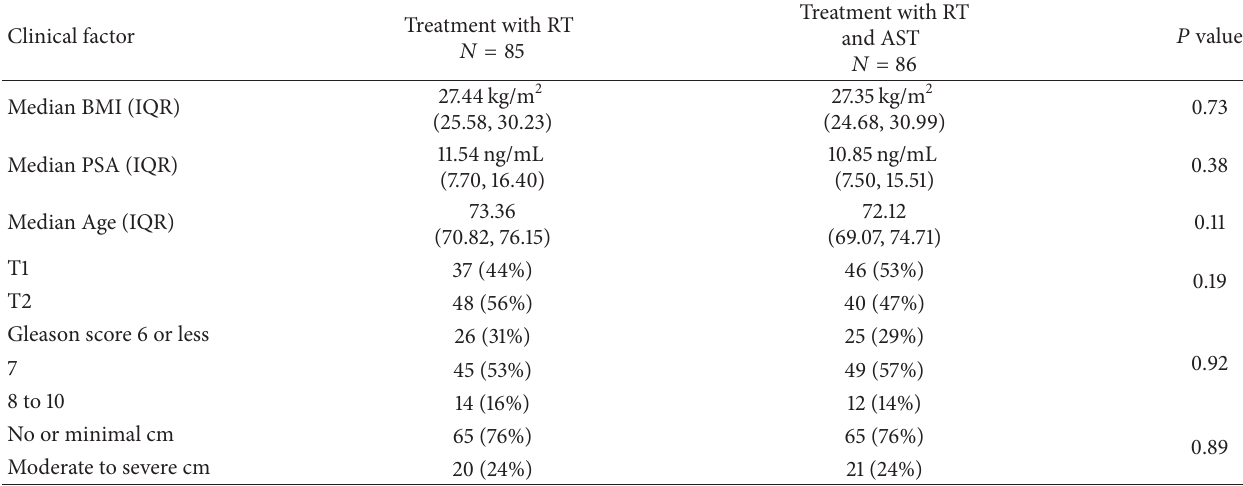
Table 1: Distribution and comparison of clinical factors at randomization of the study cohort stratified by randomized treatment arm. Clinical factor